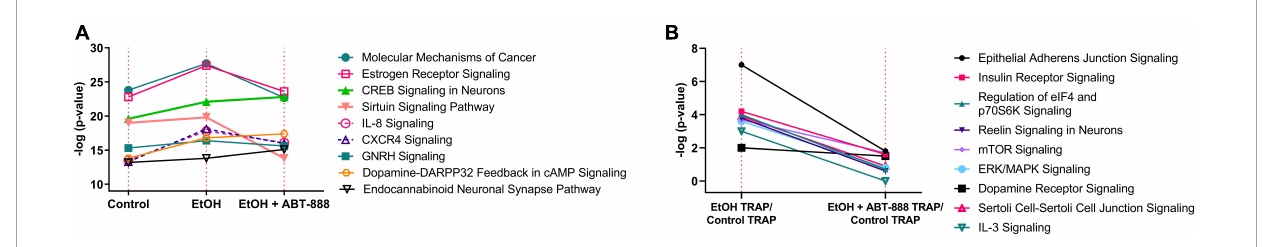
FIGURE2 Modulation of enriched signaling pathways between experimental conditions. The –log p-value scores (obtained from IPA) of nine selected pathways are plotted, showing their activation patterns between the experimental conditions in Table 1 . (A) RE (TRAP-seq) compared to total-RNA (RNA-seq) in Control, EtOH treated, and EtOH + ABT-888 treated (lines A1, A2, and A3 from Table 1 ). (B) Comparing RE only of EtOH treated and EtOH + ABT-888 treated (lines B1 and B2 from Table 1 ).